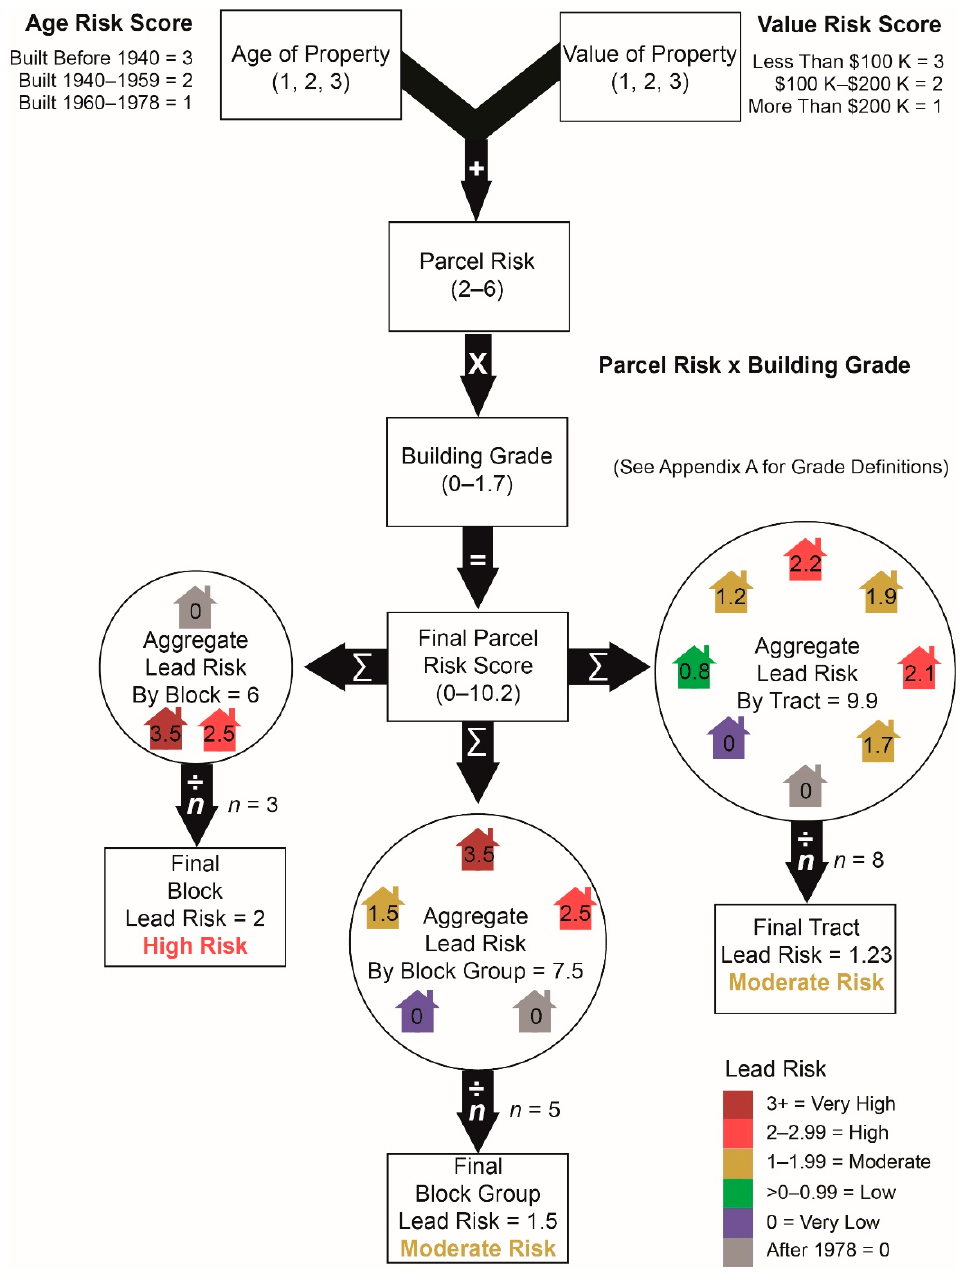
Figure 2 . Lead Risk Methodology